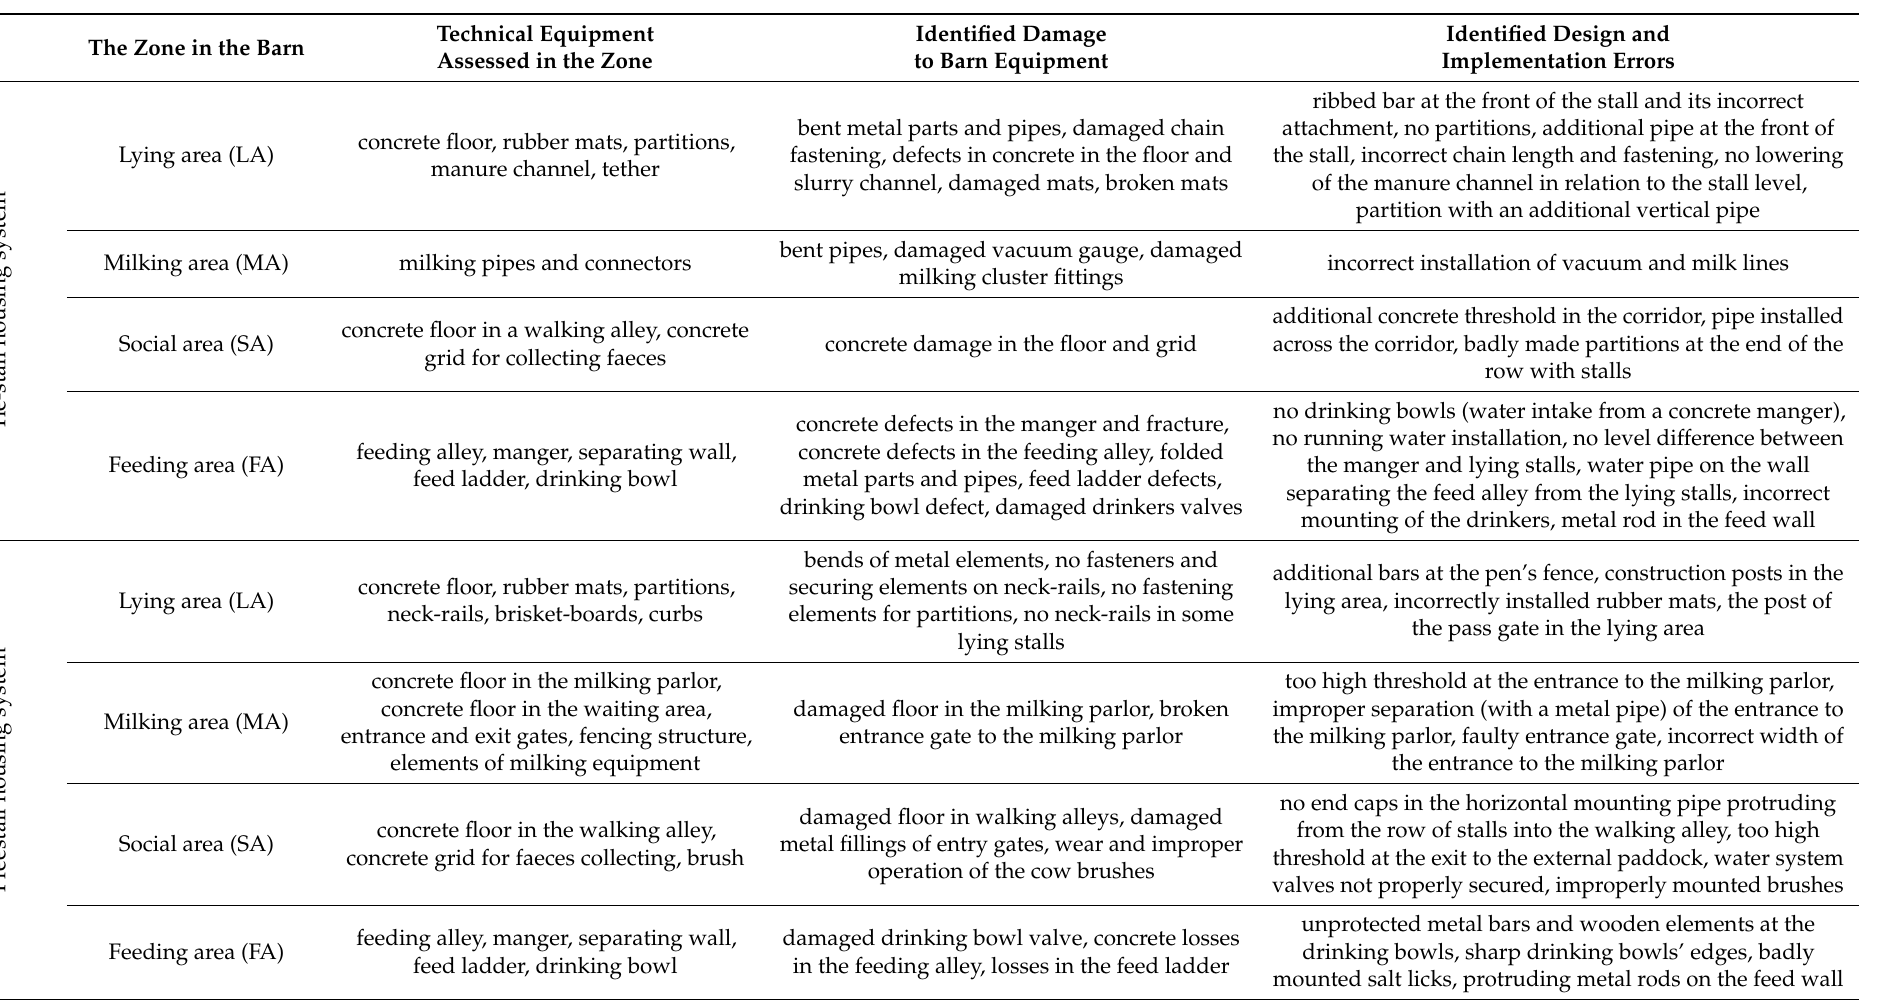
Table 3. Technical condition of the equipment and design errors assessed in four zones of barns with a tie-stall housing system and freestall housing